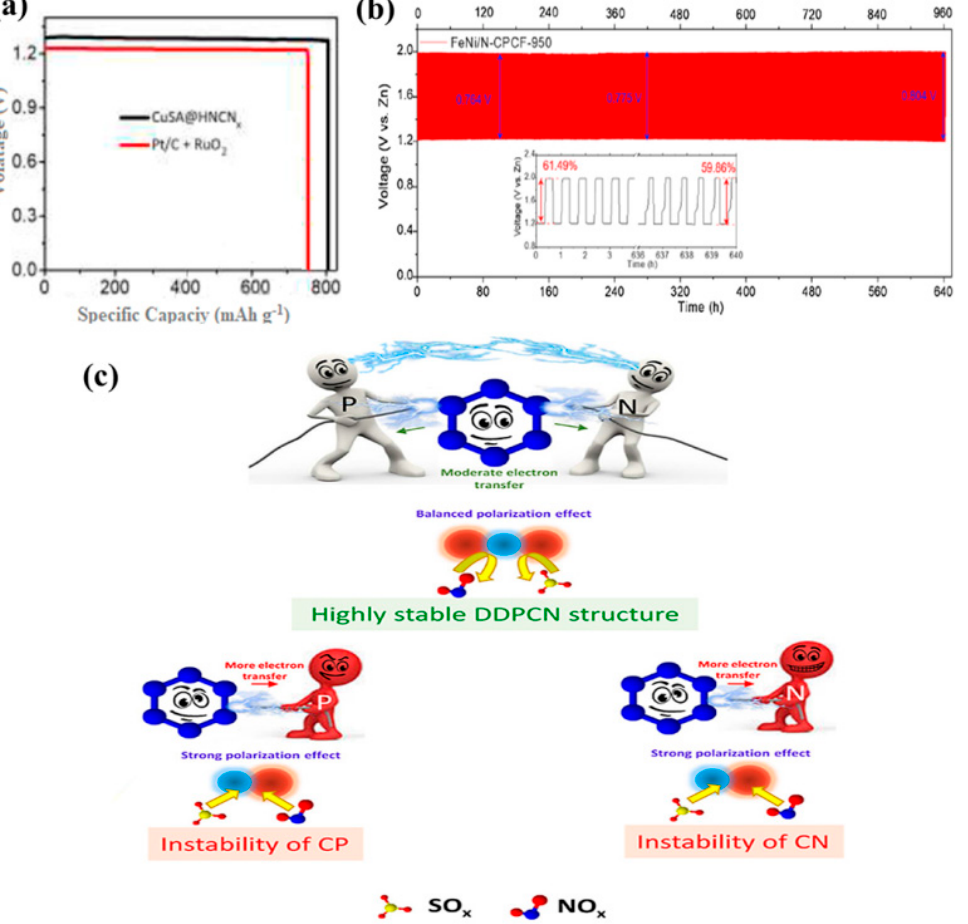
Figure 7. ( a ) Specific capacities of for CuSA@HNCNx and Pt / C + RuO 2 cathodes [85]. ( b ) The 640 h galvanostatic cycling stability of Zn-air battery with FeNi / N-CPCF-950 air cathode catalyst (at 10 mA cm − 2 ) [86].( c ) The structural resistance of P, N dual-doped porous carbon nanospheres (DDPCN), nitrogen-doped carbon (CN), and phosphorous-doped carbon (CP) for the incoming small molecules NO x and So x [92].